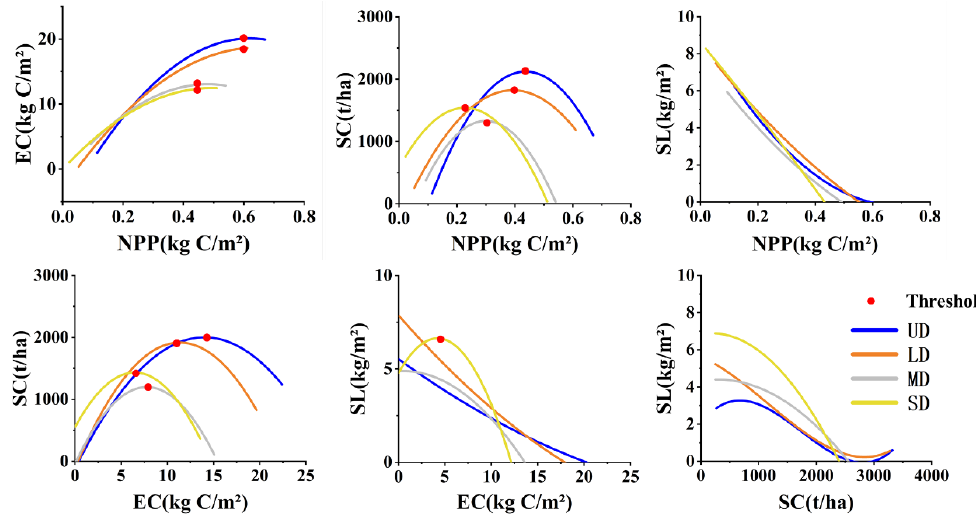
Figure 6. Constraint effect of grassland degradation on paired ecosystem services in the study area, from 2000 to 2019. UD, undegraded grassland; LD, lightly degraded grassland; MD, moderately degraded grassland; SD, severely degraded grassland; NPP, net primary production (kg C/m 2 ); EC, ecosystem carbon (kg C/m 2 ); SC, soil conservation (t/ha); SL, soil loss by wind (kg/m 2 ). With the increase in NPP, EC increased, but the increase in EC was constrained when NPP increased to a certain threshold, which was related to the grassland degradation